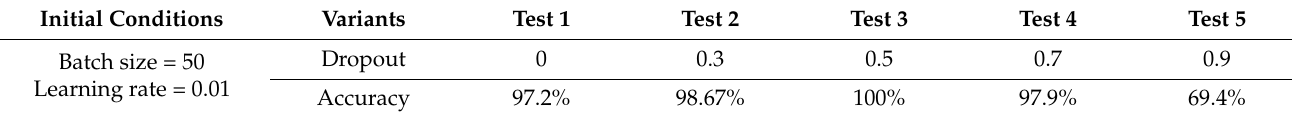
Table 5. Experiments for selection of optimal dropout using Dataset 1.